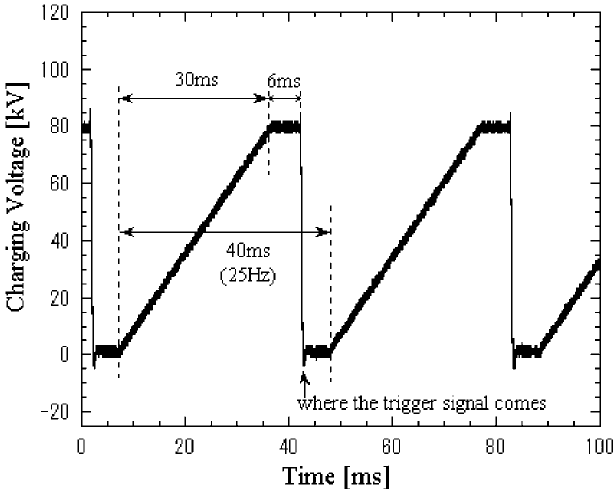
FIG. 2. Charging voltage